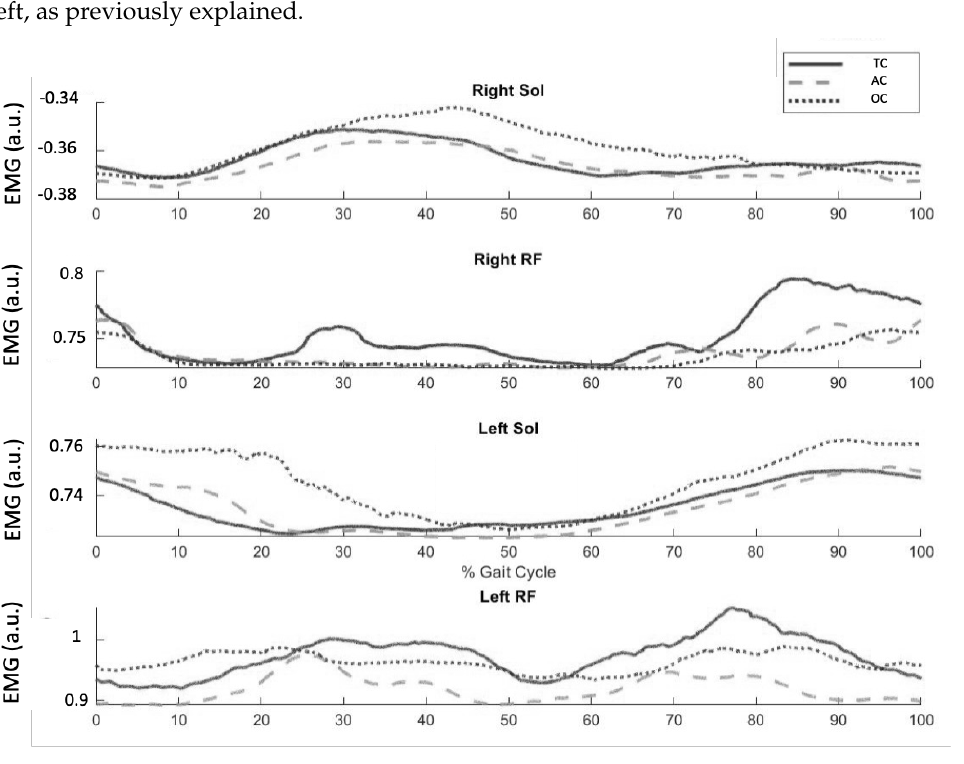
Figure 8. Normalized and cycle-averaged EMG envelopes of Sol and ReFe muscles. Higher EMG activation was observed in both Sol for the OC walking condition com- pared to the TC and AC walking conditions. With respect to the ReFe muscles, the TC walking condition resulted in increased muscle activation compared to AC and OC condi- tions. These results suggest that the EMG-Onset algorithm required the user to increase the muscle activation of the Sol while decreasing the ReFe activation in order to trigger the